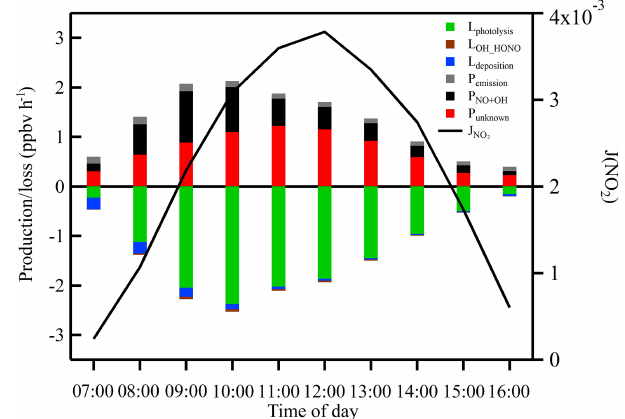
Figure 9. Averaged production and loss rates of daytime HONO and J( NO 2 ) during the measurement period. The black line shows the photolysis rate of NO 2